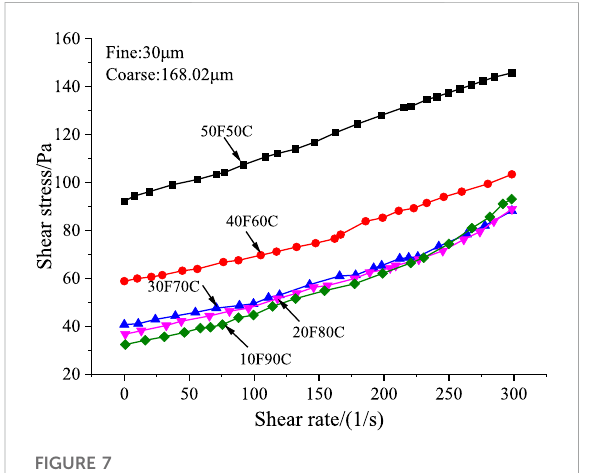
FIGURE 7 The shear stress-hear rate rheological curve of particle diameter 30.0 μ m.